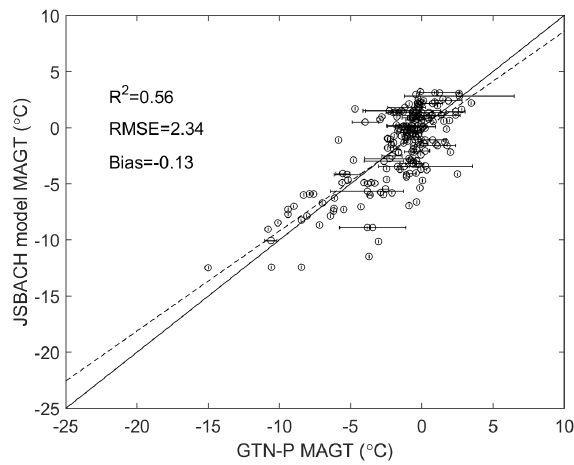
Figure 1. Evaluation of mean annual ground temperature against GTN-P borehole measurements. Model results are taken from the depth of observation for each point.